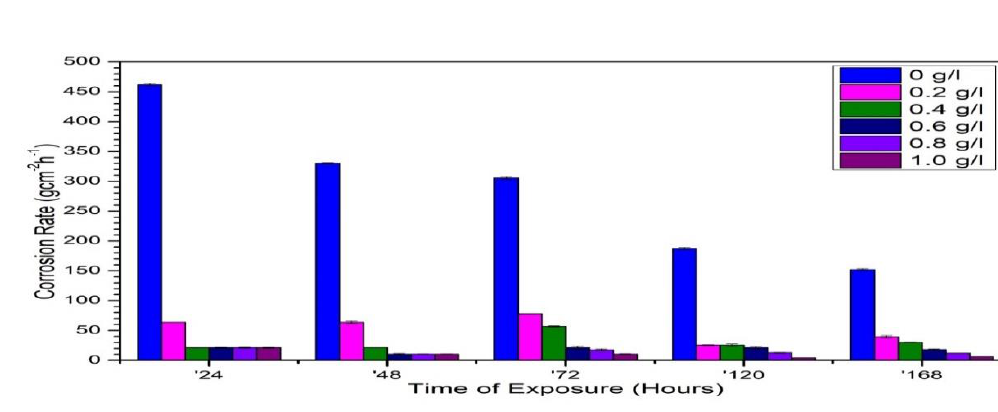
Figure 9: the variation of corrosion rate in Prosopis Africana seed extracts